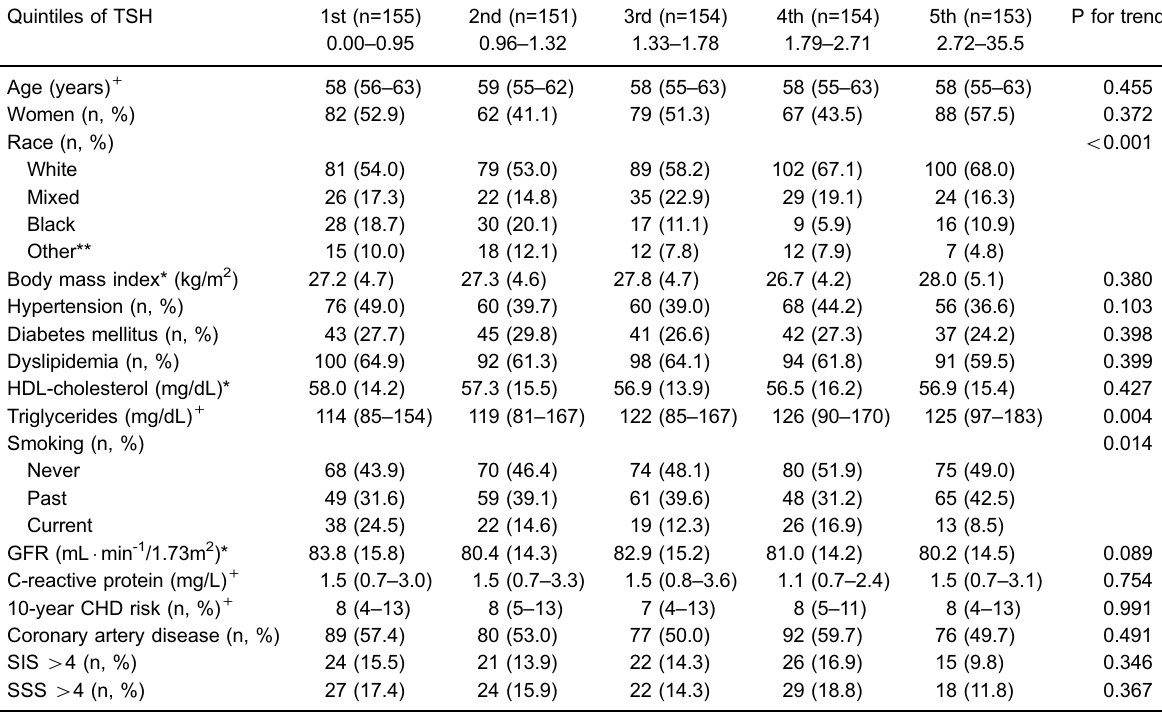
Table 1. General characteristics of the sample according to the quintiles of thyrotropin (TSH). Quintiles of TSH